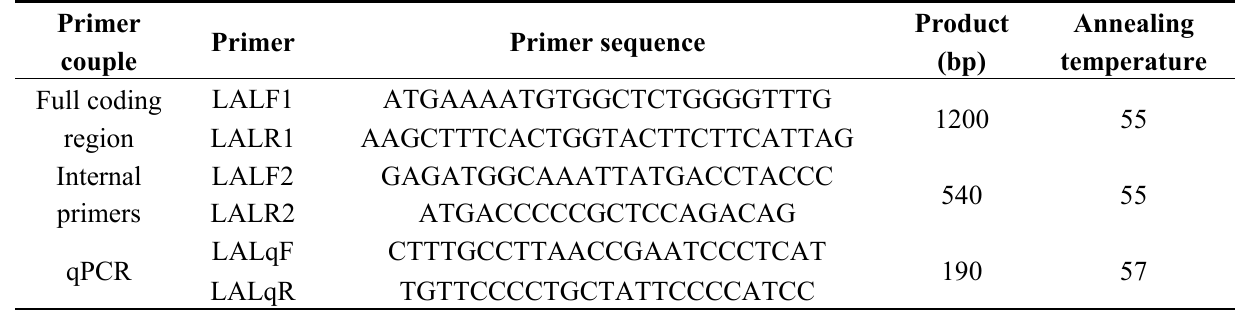
Table 3. List of primers used for the amplification and qPCR studies